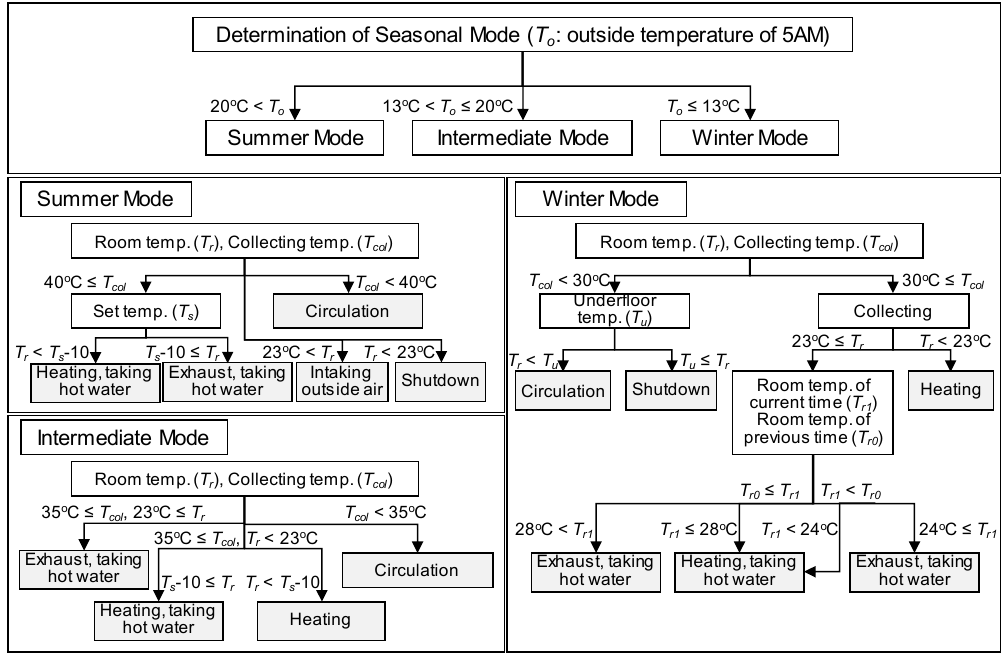
Figure 8. Hot water supply load of a typical house.